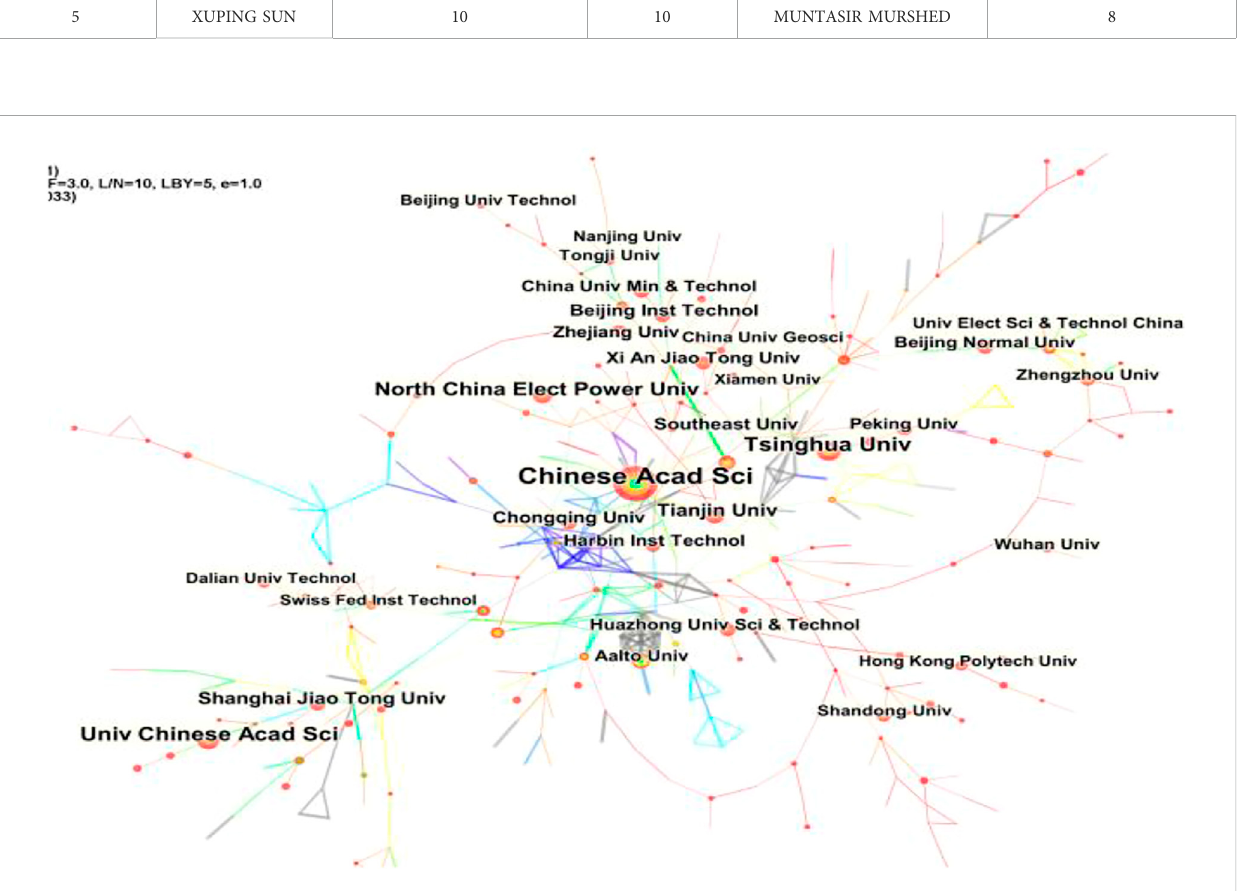
FIGURE 2 Institutional cooperation